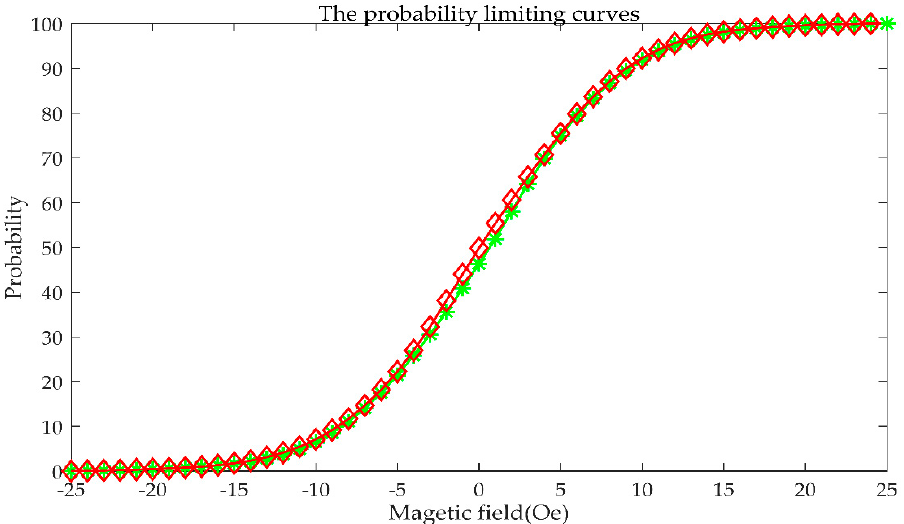
Figure 8. The limiting curve of the probability model.